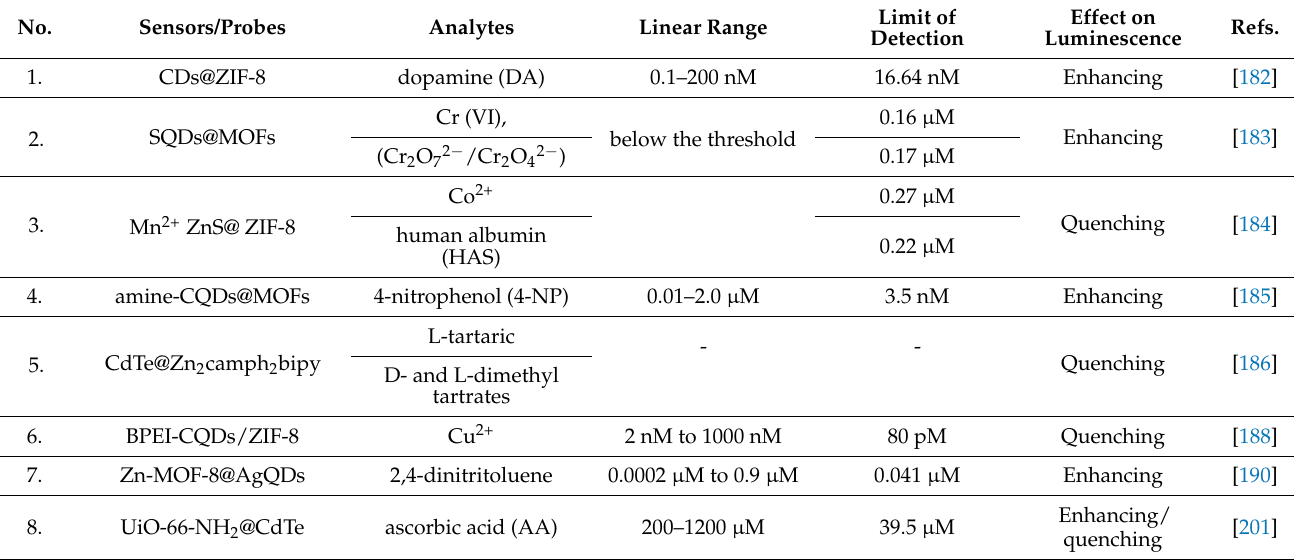
Table 4. Summary of binary quantum dots metal–organic framework composite sensors/probes for the detection of harmful